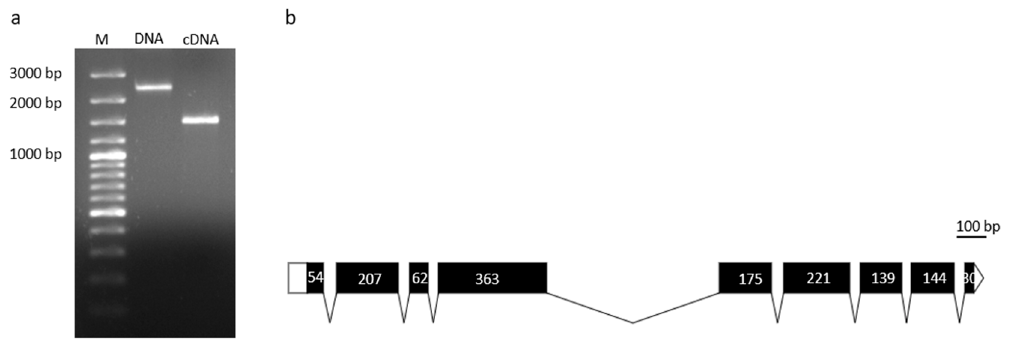
Figure 2. Molecular characterization of BxFUCA2. Amplicons of genomic DNA (2332 bp) and cDNA (1491 bp) coding sequences ( a ). Schematic representation of Bxfuca2 gene structure ( b ). Relative positions and respective sizes of exons are indicated as dark boxes and introns as lines.